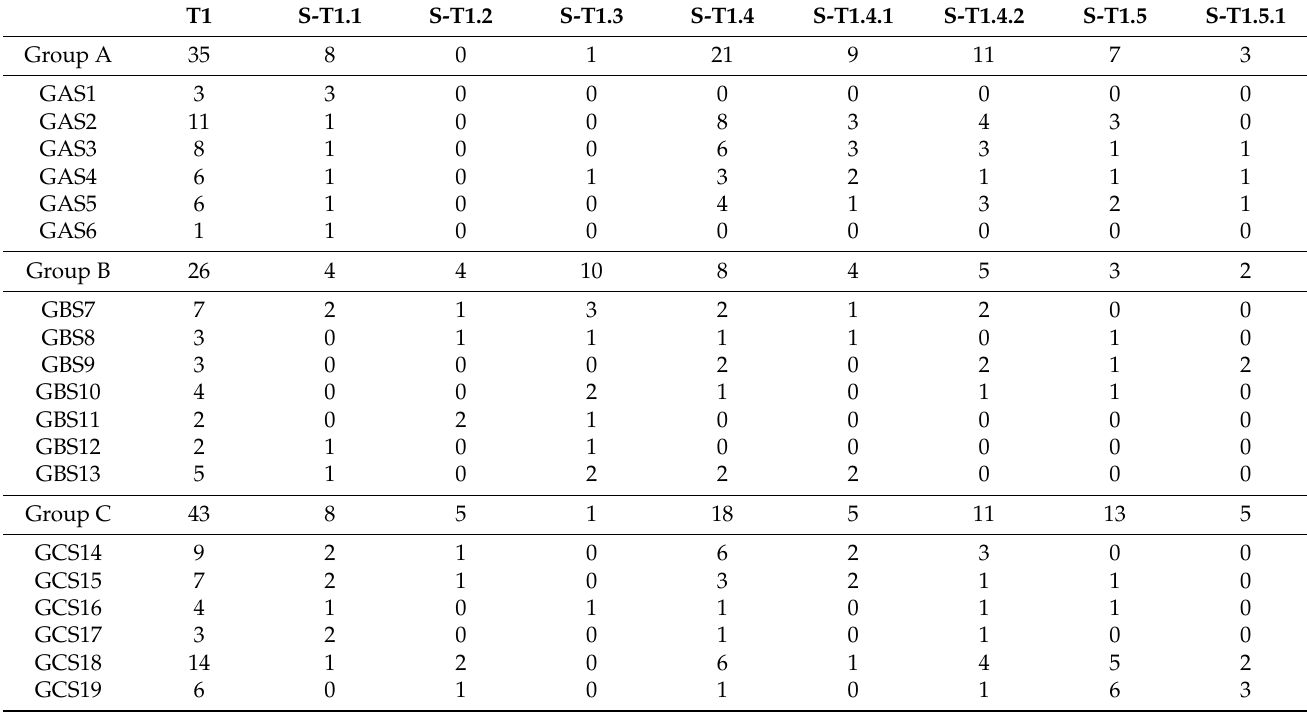
Table 3. Distribution of occurrences per participant on the theme 1 and the related sub-themes (S-T1.1, S-T1.2, S-T1.3,